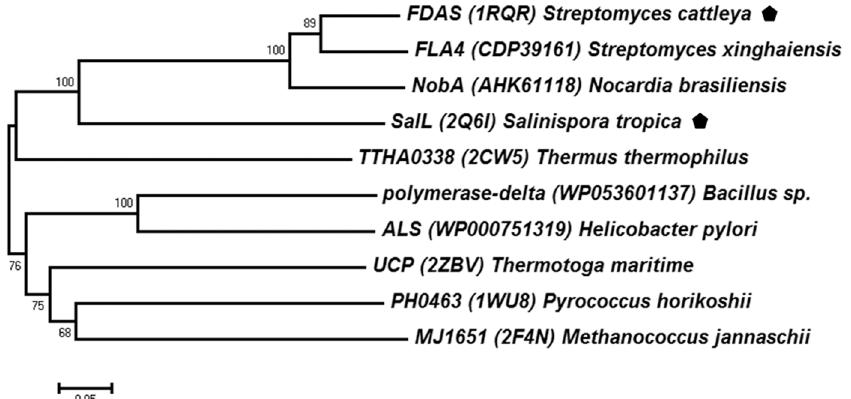
Fig 5. Evolutionary relationships between the S-HG and the SAM hydroxide adenosyltransferases. The phylogenetic tree was reconstructed using the Neighbor-Joining method. The representative S-HG enzymes are marked